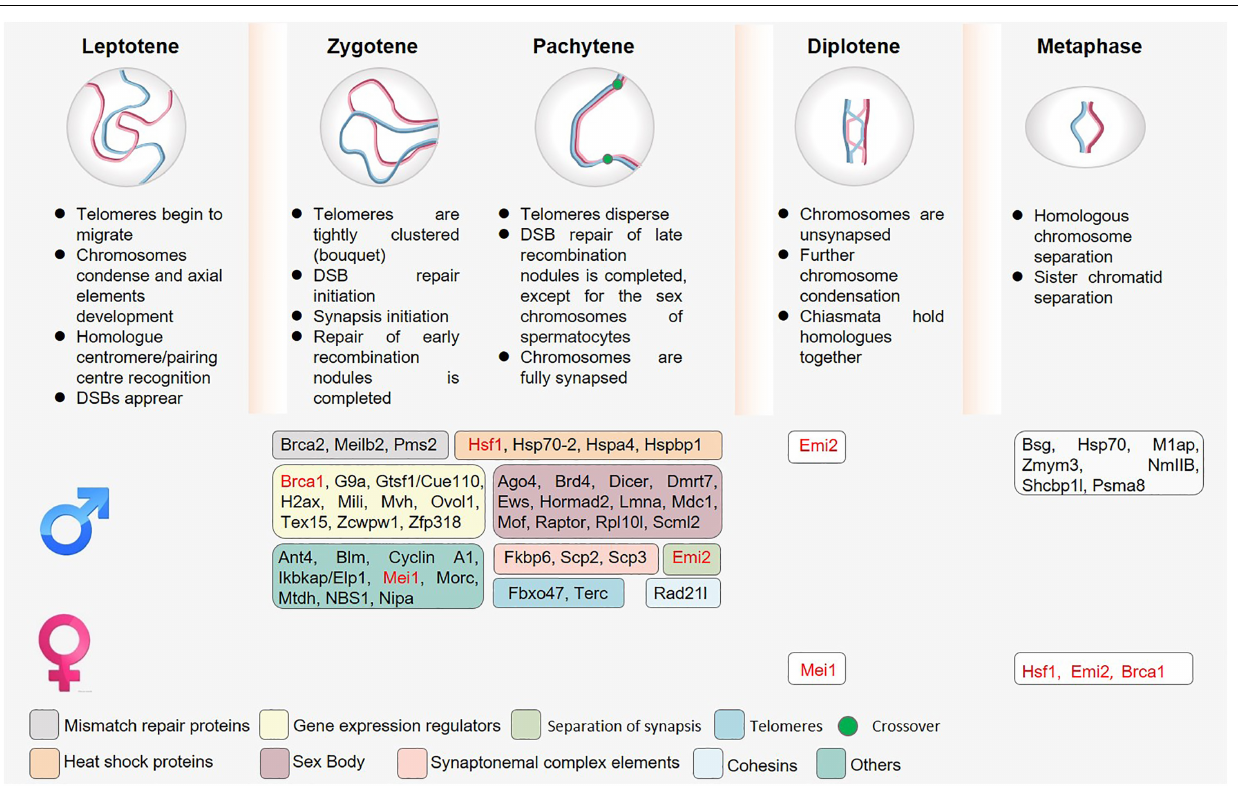
FIGURE 2 | The roles of sex-specific regulatory proteins in meiosis. Owing to overlap in the timing of telomere attachment and movement, double-strand break (DSB) repair, and MSCI, the knockout of proteins associated with these meiotic processes often results in multiple complex phenotypes. Spermatocytes have additionally evolved to express many different sex-specific proteins (shown in boxes). Proteins marked in red indicate the presence of a meiotic phenotype after knockout in both spermatocytes and oocytes, although these phenotypes are not consistent in these two cell